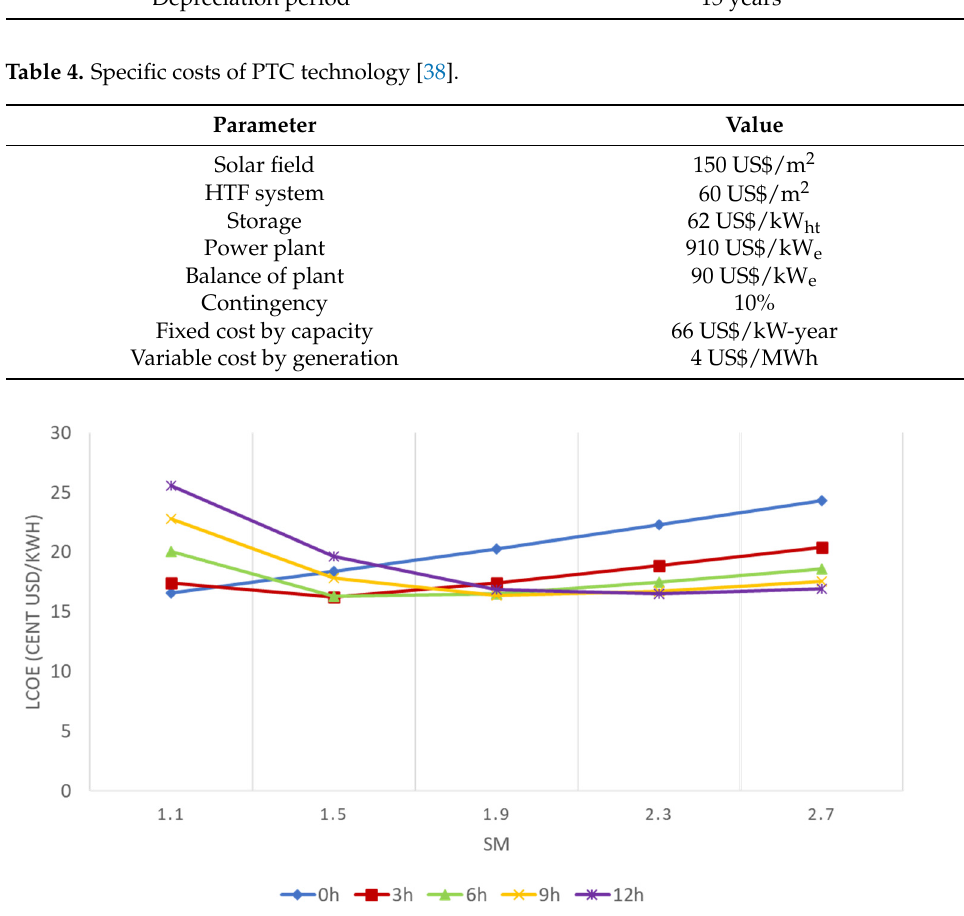
Figure 2. Effect of solar multiple and thermal storage on the LCOE.